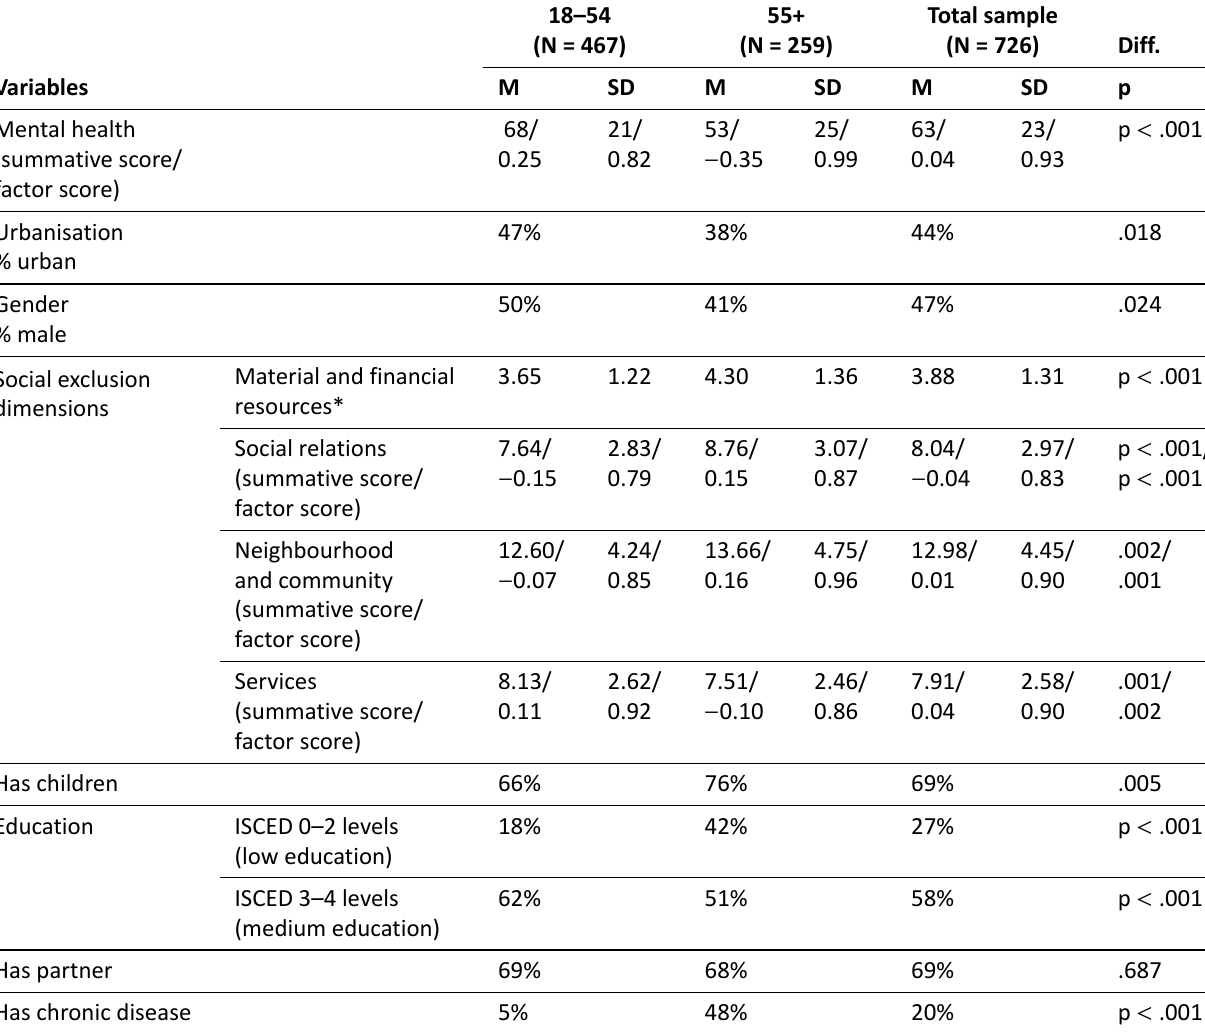
Table 1. Descriptive statistics of the total study sample and by age